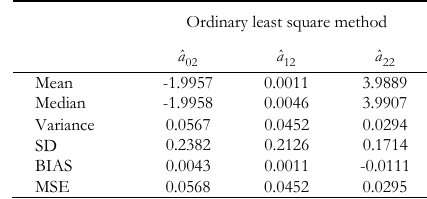
Synthesised results of the simulations referred to the simplified procedure based on the ordered means and to the ordinary least square method for N = 1000 and r = 2 Simplified procedure based on ordered means Ordinary least square